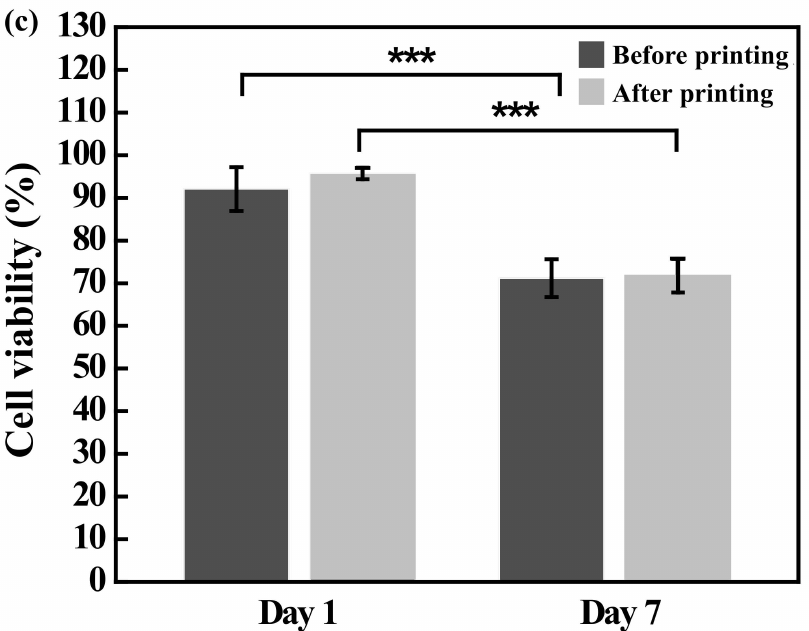
Figure 9. Live/Dead analysis results of cell viability of the optimal bioink GBH-2: ( a ) before print- ing (without printing treatment), ( b ) after printing (with printing treatment), and ( c ) quantitative measurement analysis (*** p <